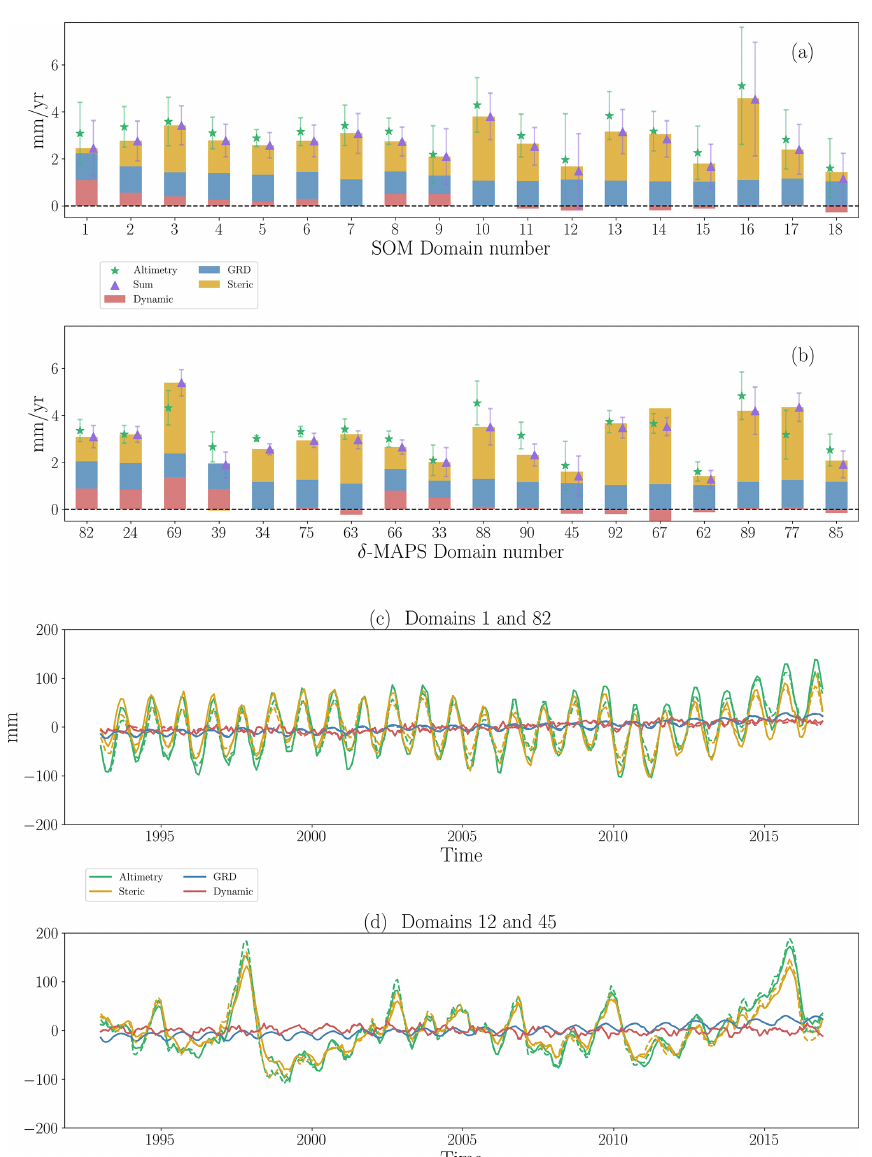
Figure 4. Sea-level budget trends (mmyr − 1 ) for (a) SOM and (b) δ -MAPS domains and (c, d) time series for two example domains, where solid and dashed lines indicate SOM and δ -MAPS time series, respectively. The location of each domain is shown in Fig. 2 (domain numbers in magenta for δ -MAPS). For comparison, δ -MAPS domains are matched to the SOM domains, for example SOM domain 12 to δ -MAPS domain 45. A bar plot for all other δ -MAPS domains can be found in Fig. A4. Error bars indicate the 1 σ uncertainty of the trend. Time series for all SOM domains and for the 18 δ -MAPS domains in (b) are shown in Fig. A5. An interactive budget map is available at https://carocamargo.github.io/resources/regional-SLB-domains/ (last access: 9 January 2023) for both SOM and δ